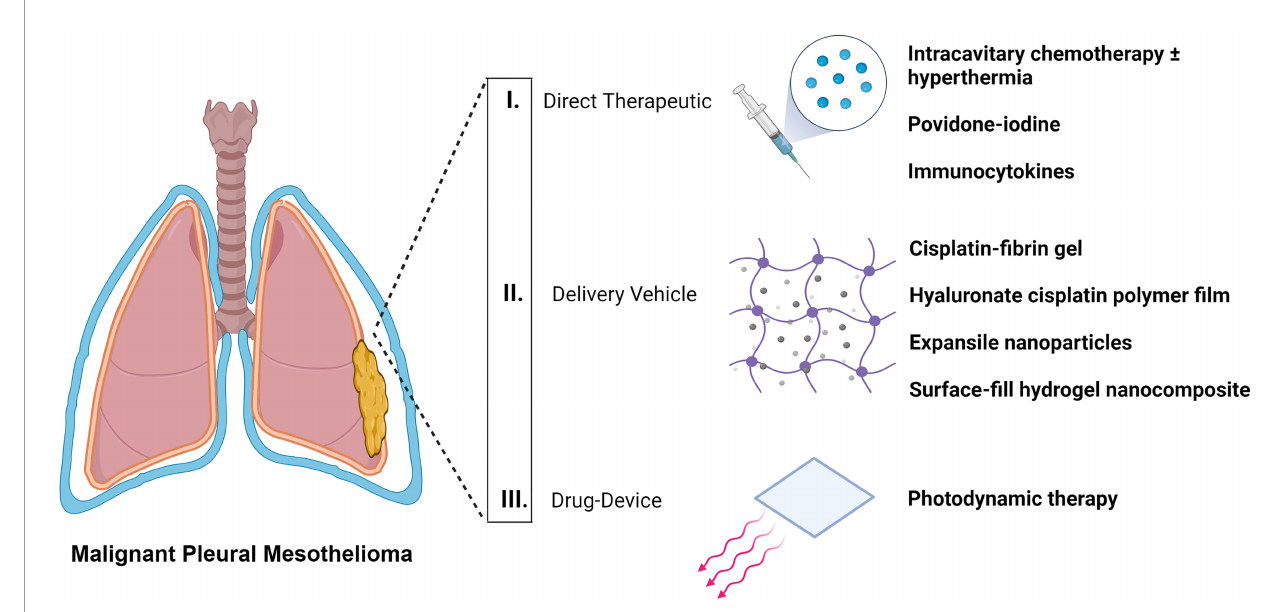
FIGURE 1 | Classi fi cation of locoregional pleural-directed adjuncts for surgical-based therapy of